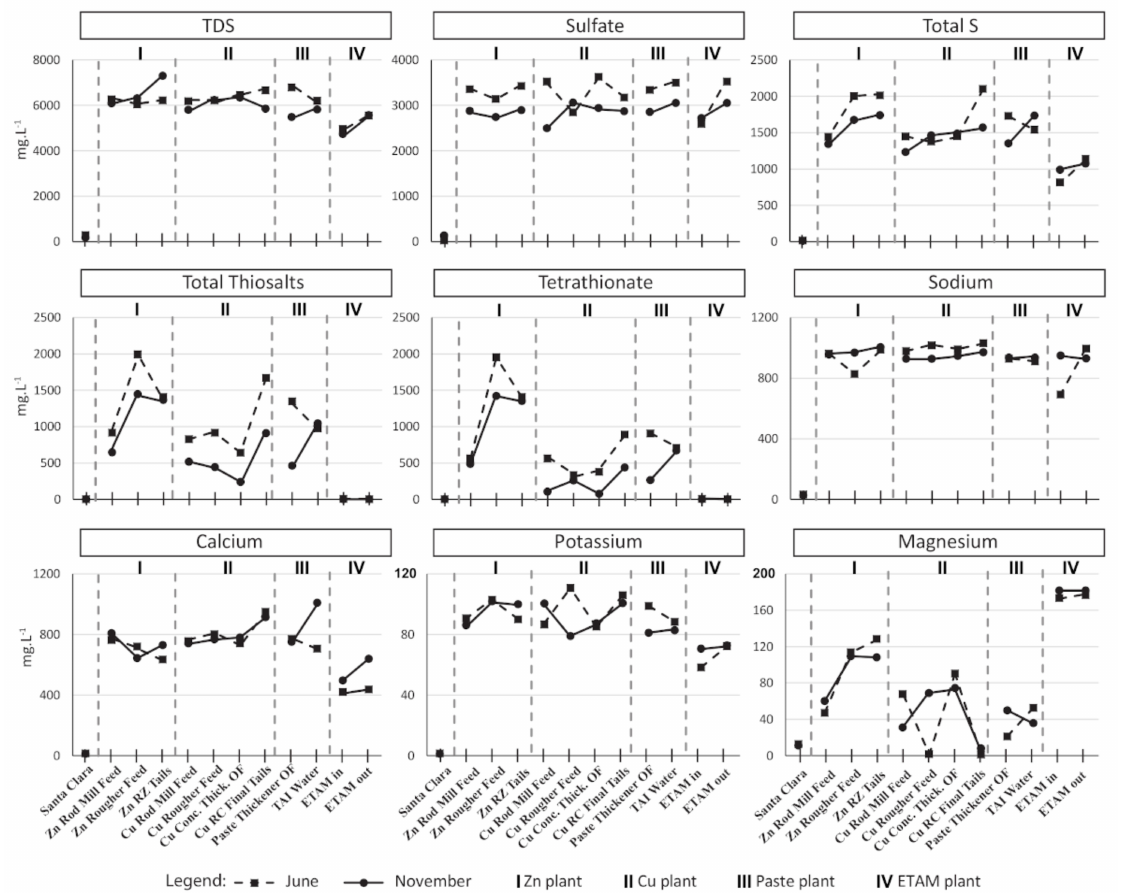
Figure 3. The profiles of major chemical compounds throughout the plants and water circuit. TDS, total dissolved